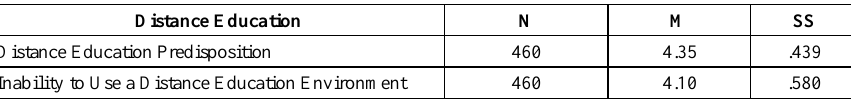
Table 4. Distance education status of mechanical engineer programme candidates Distance Education